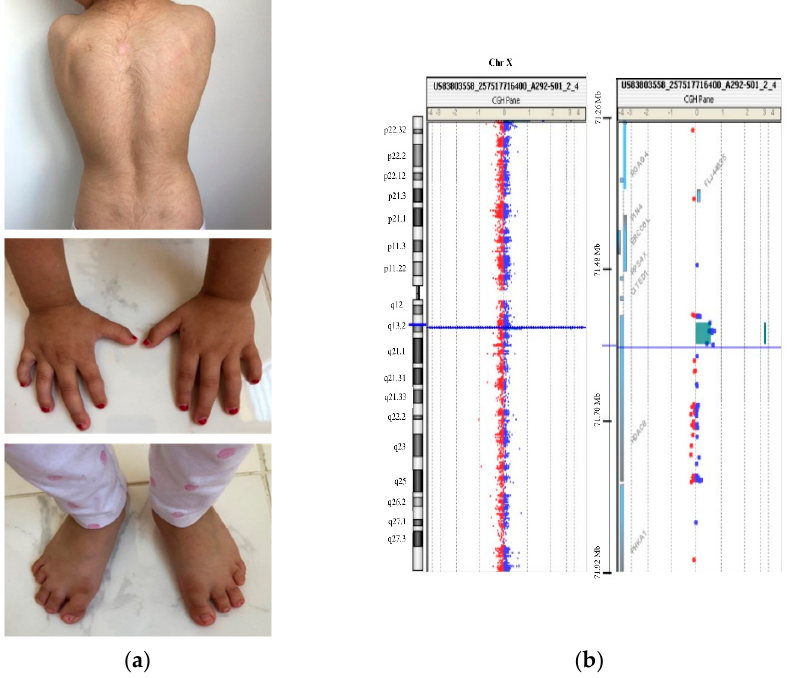
Figure 1. Clinical and genetic description of the patient. ( a ) Patient at 5 years showing her back with hirsutism and small hands and feet with clinodactyly of the fifth finger (more details in the text); ( b ) CytoSure Constitutional v3 array 8 × 60K array-CGH result showing a 0.032 Mb duplication at Xq13.1 in the patient.